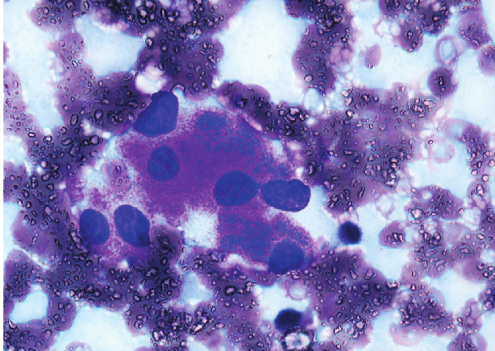
Figure 5: Negative cytokeratin immunohistochemistry, bone mar- row trephine × 200.